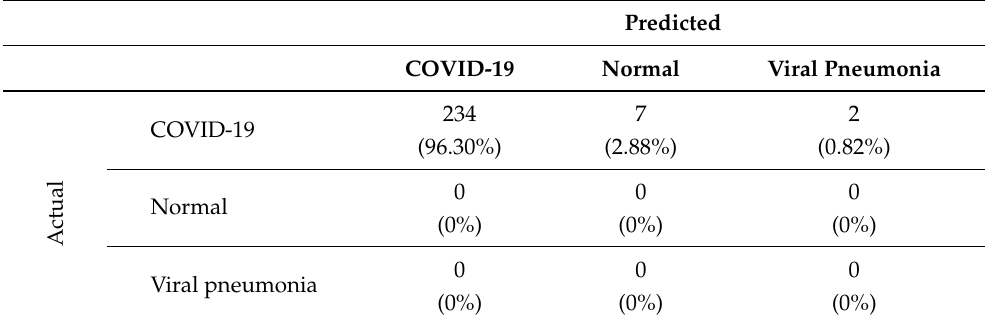
Table 4. Confusion matrix for the EfficientNetB4-based Approach 1 (end-to-end) without additional training or fine-tuning on the unseen COVID-19